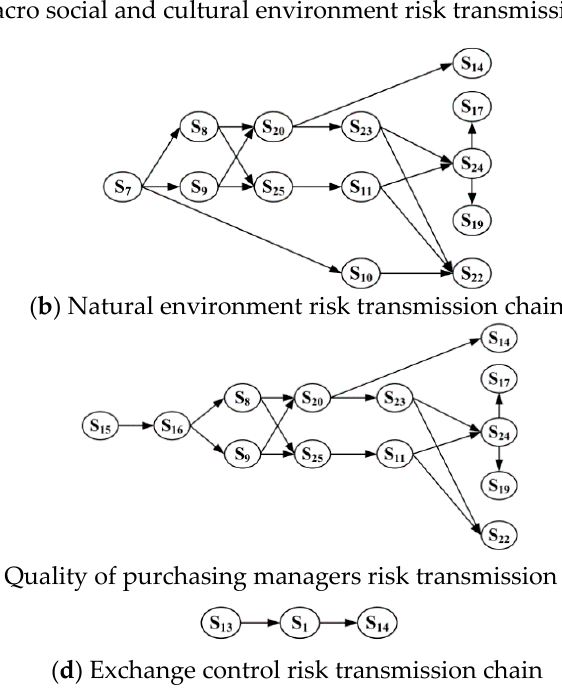
Figure 6. Procurement risk transfer path.